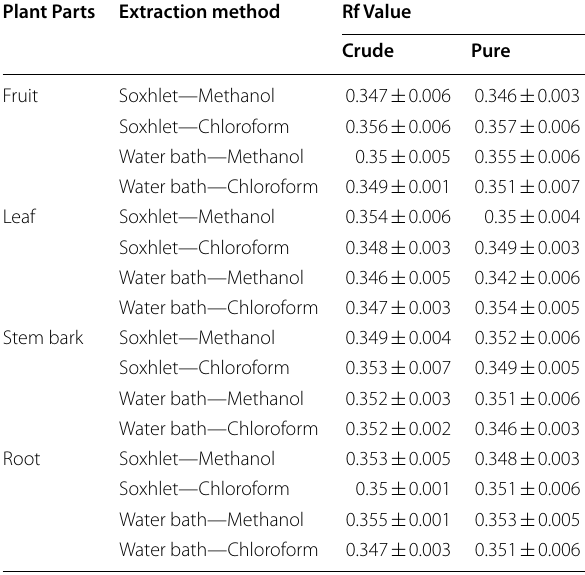
NB-Data are expressed as mean